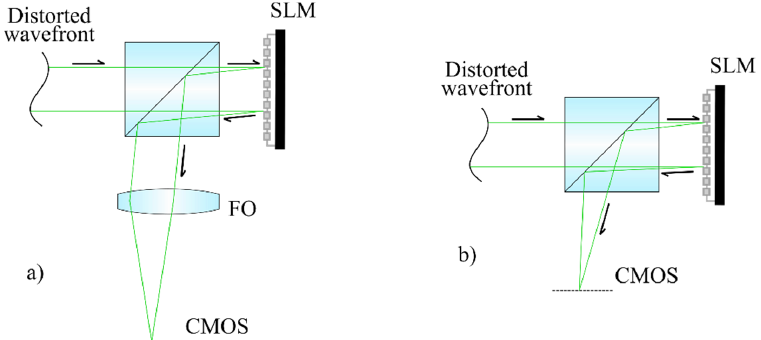
Figure 3. The optical scheme of the wavefront sensor with a Fourier transform lens ( a ) and the proposed scheme with a digital Fresnel lens ( b ). scheme with a digital Fresnel lens ( b